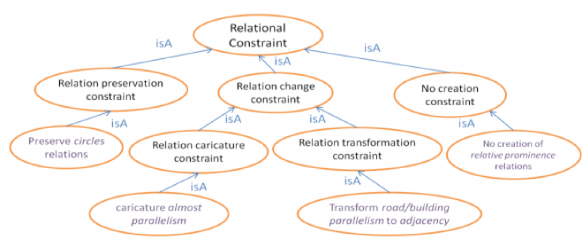
Figure 1: Operator ontology